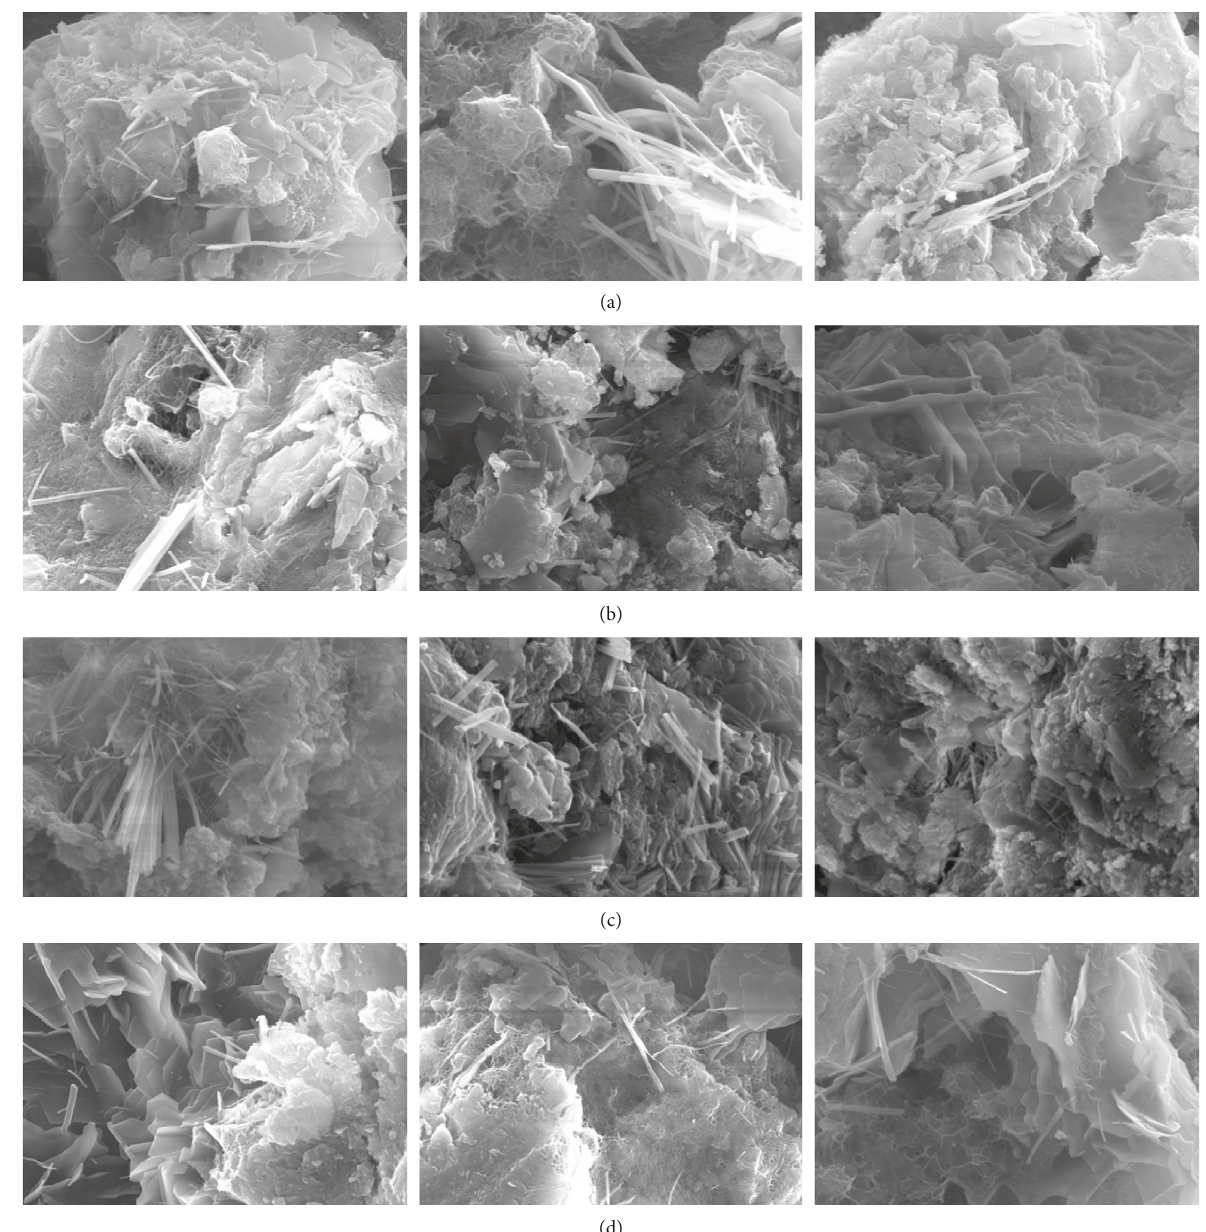
Figure 5: Electron microscope scan of slurry stone body 1d, 3d, and 5d with fly ash content: (a) 10%. (b) 15%. (c) 20%. (d) 30%.